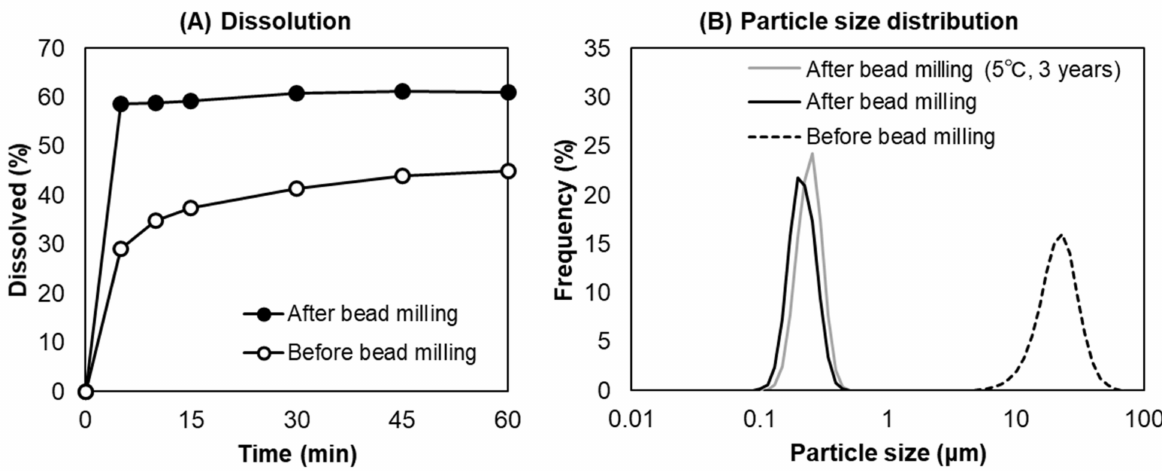
Figure 2. Dissolution ratio of the PHT suspension as a function of the dissolution time ( A ) and the particle size distribution of the PHT suspension before and after bead milling ( B